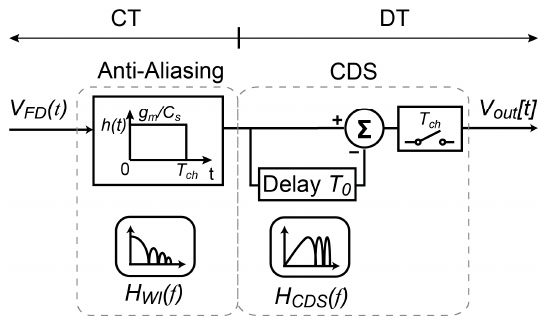
Figure 3. Block diagram model of the charge-domain correlated-double sampling (CDS).